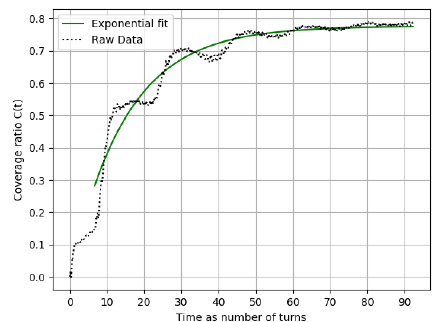
Fig. 3 : Evolution of the coverage ratio C(t) against time for the same parameters as in Fig.